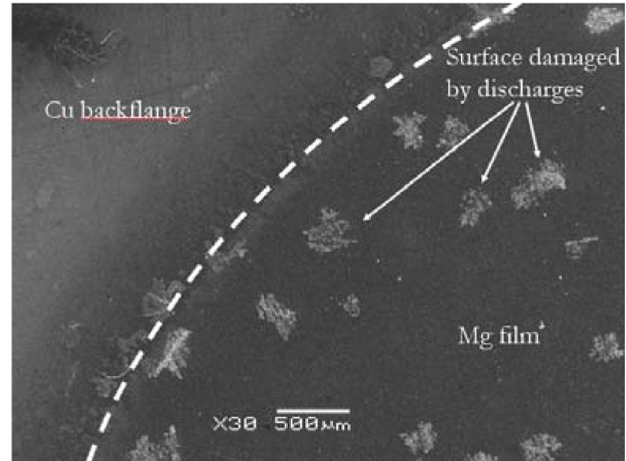
FIG. 7. Linear relationship between normalized emittance and laser distribution standard deviation: experimental data and best